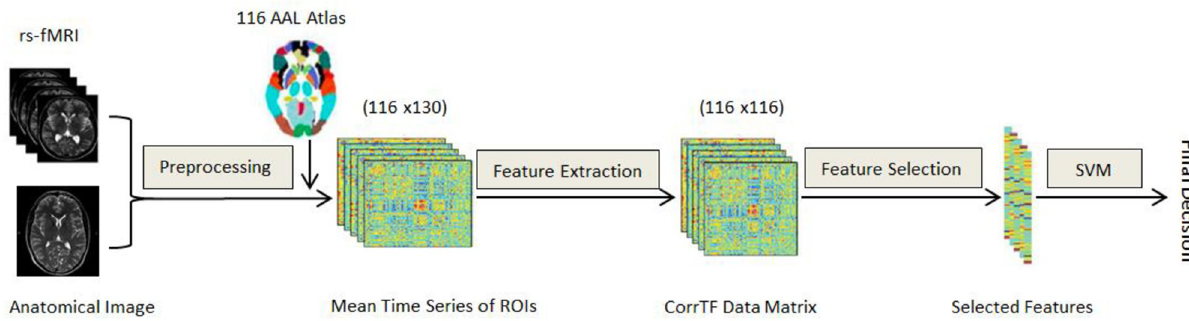
Fig 1. Block diagram of the AD diagnosing model using CorrTF features and